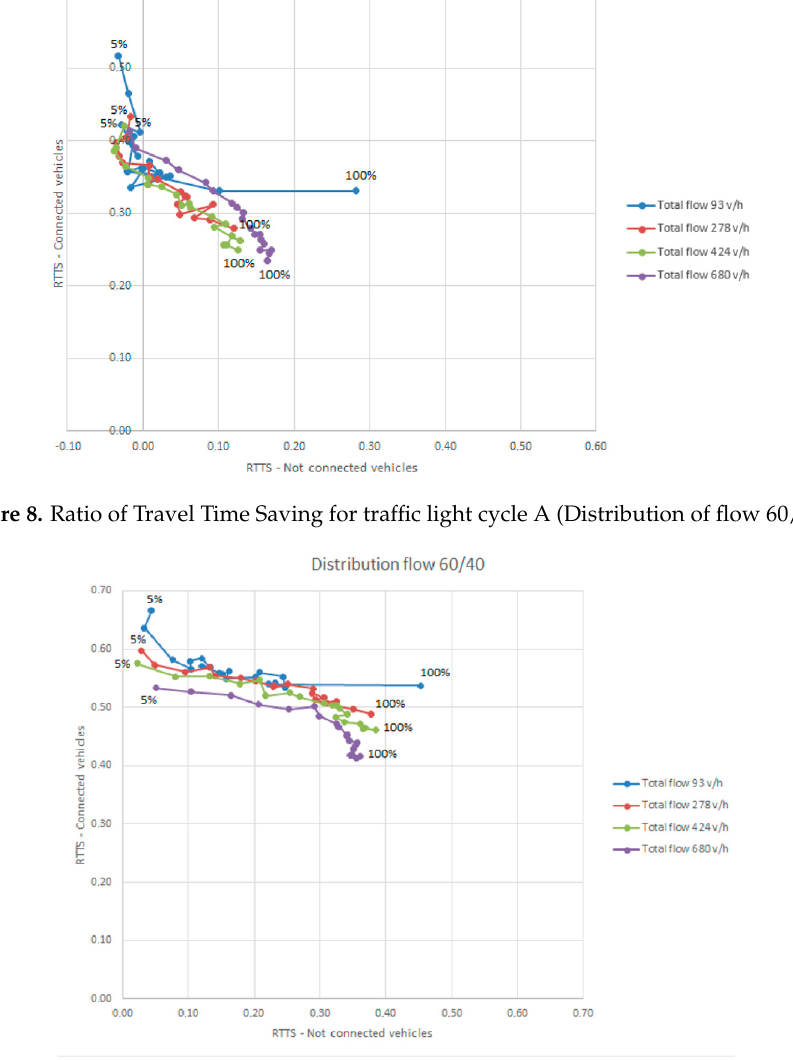
Figure 10. Ratio of Travel Time Saving for traffic light cycle A (Distribution of flow 80/20).